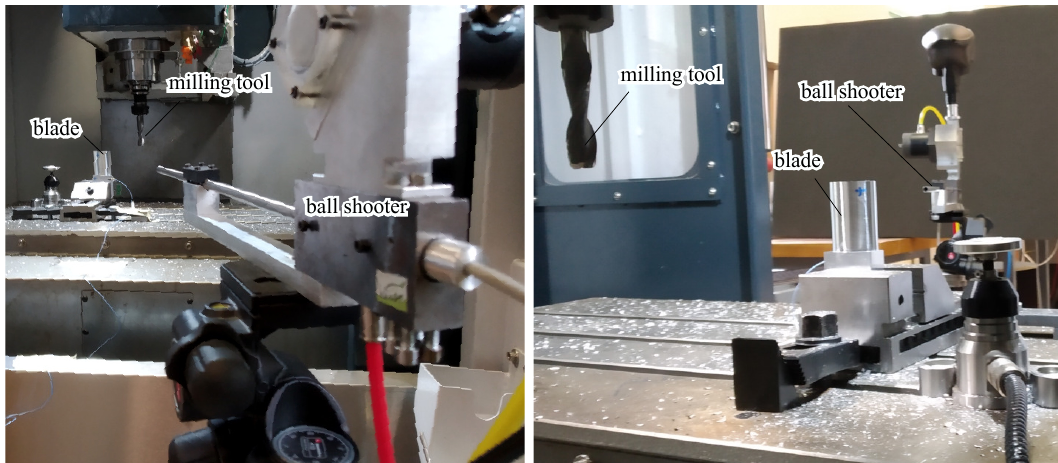
Figure 8. The measurement setup with the ball shooter and the clamped workpiece at the final stage of the machining of the blade profile ( s = 50